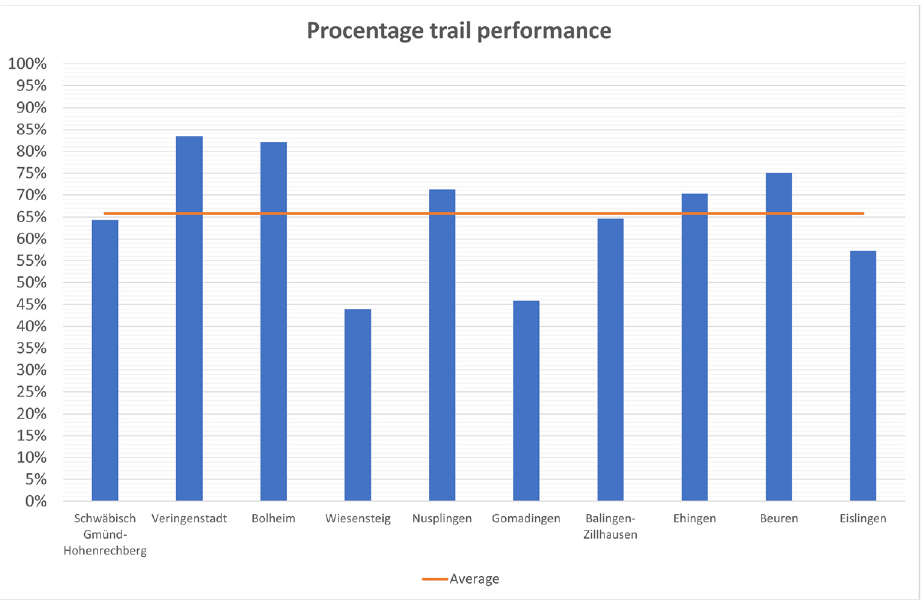
Figure 19. Degree of target achievement of the analysed paths (Julian Stolz 2022).